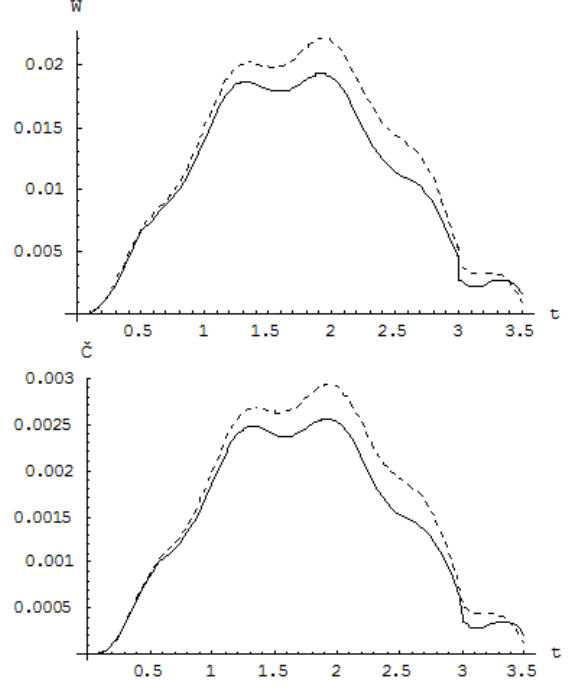
Figure 34: The vertical-torsional motion of the middle of the bridge for υ = 20 m/s and for damped vehicle ( __ ) , simple vehicle ( - - - ).